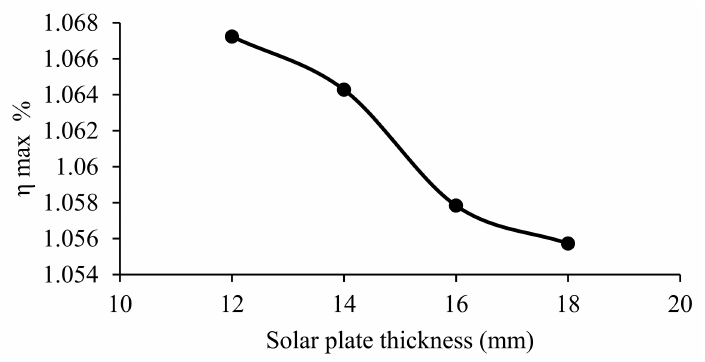
Figure 9. The relation between solar plate thickness and TEG efficiency.